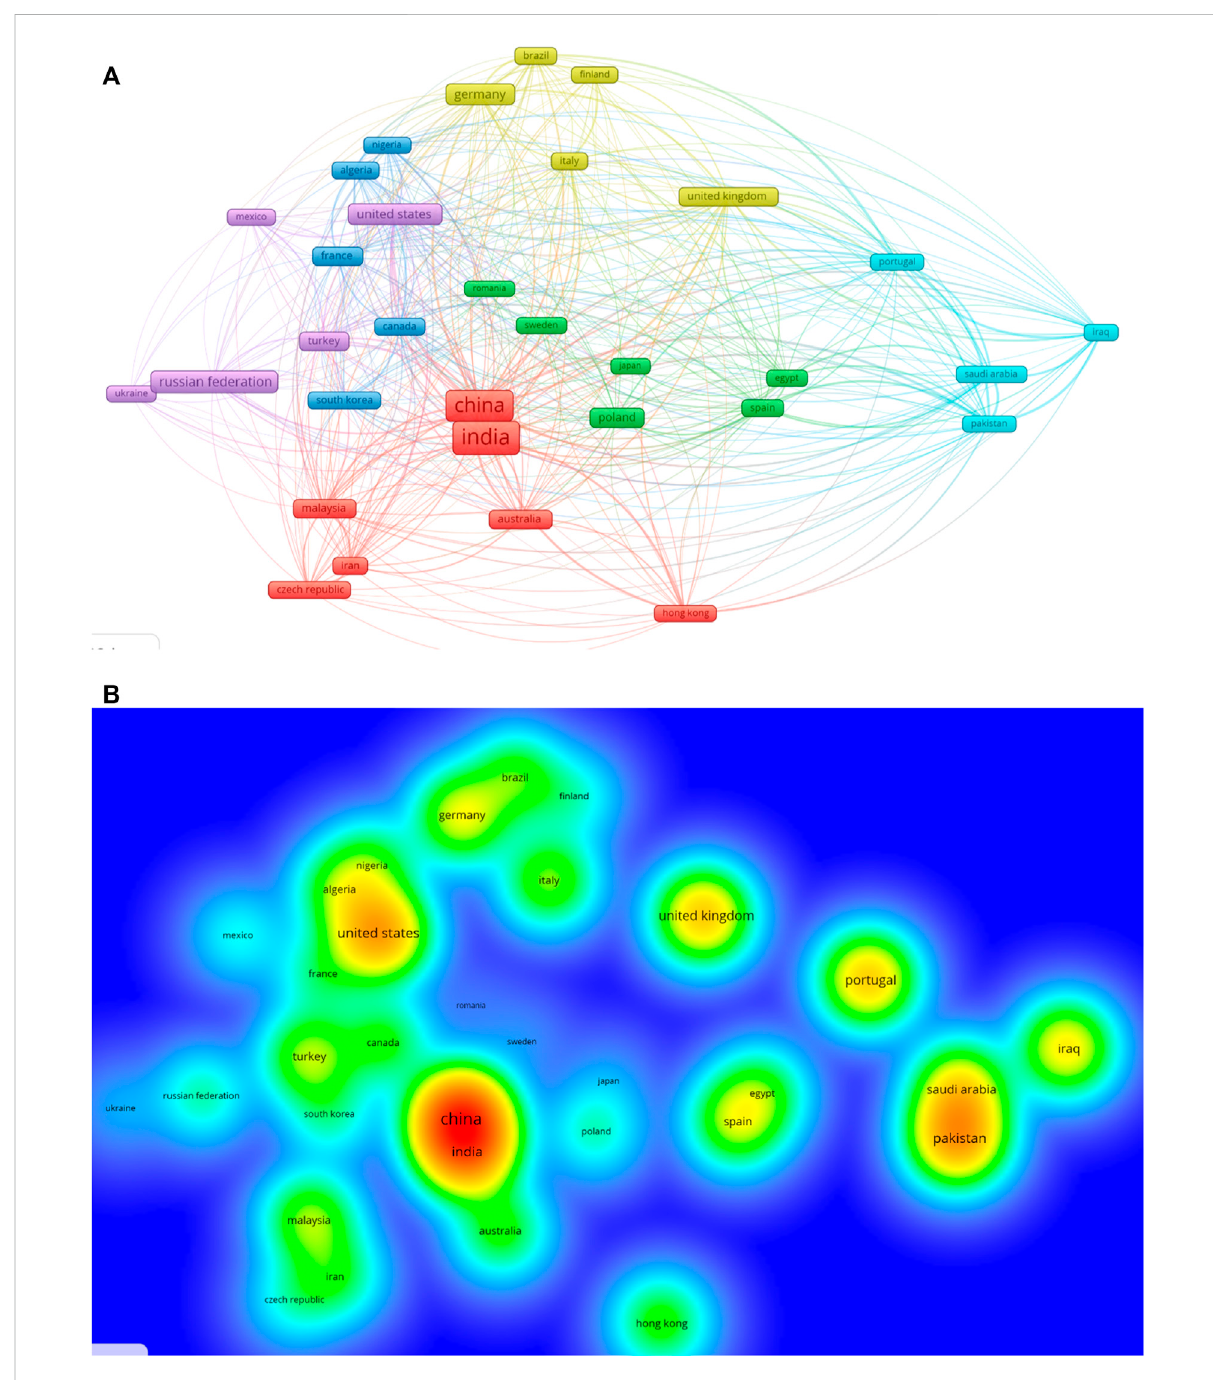
FIGURE 10 Systematic mapping of countries having at least 10 publications. (A) network map; (B)